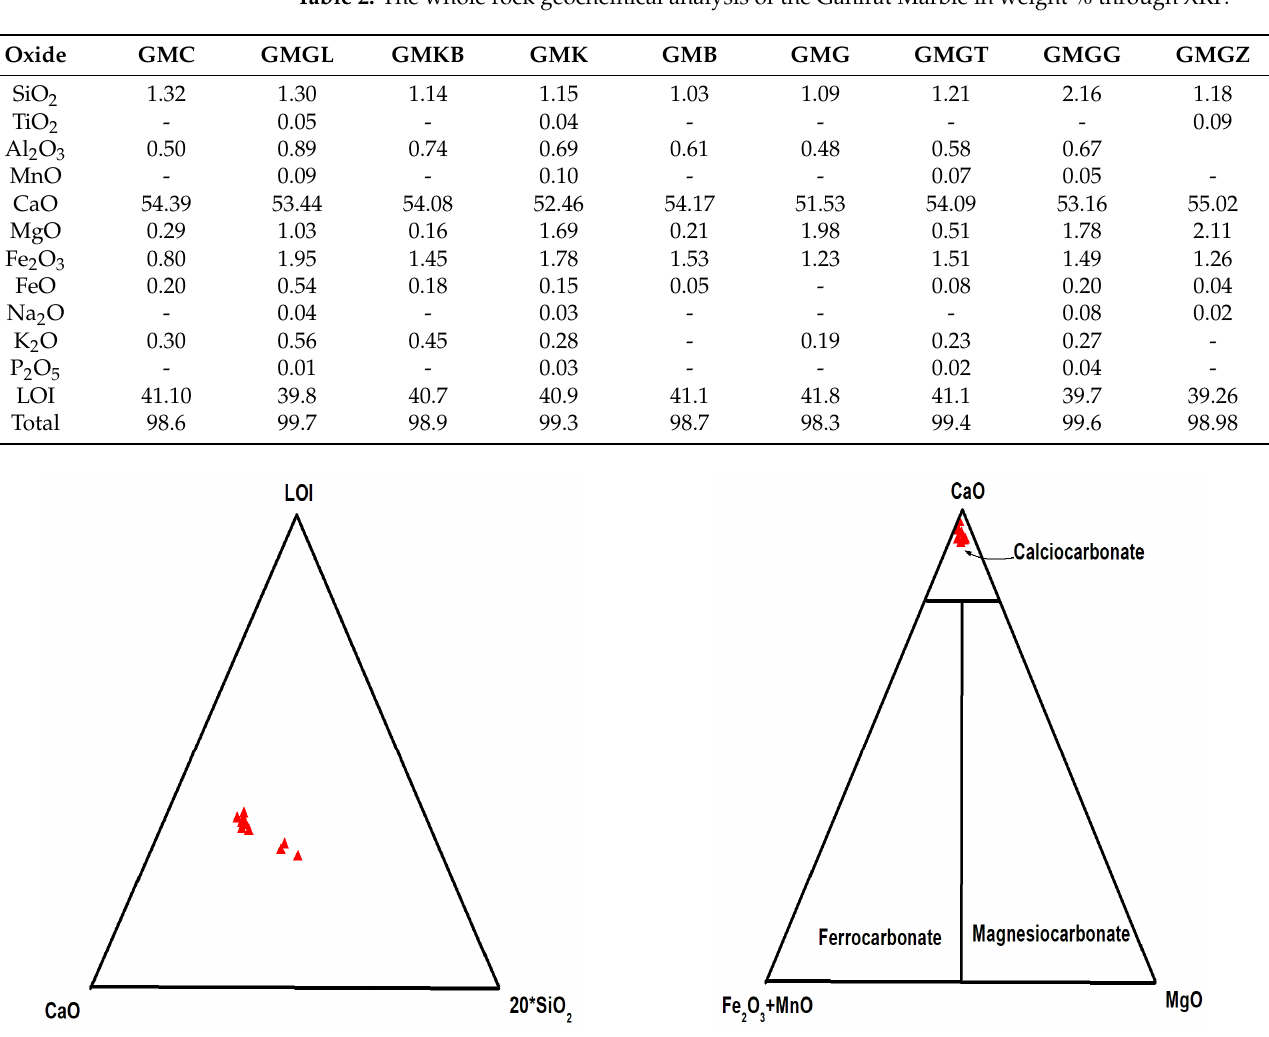
Table 2. The whole rock geochemical analysis of the Gahirat Marble in weight % through XRF.